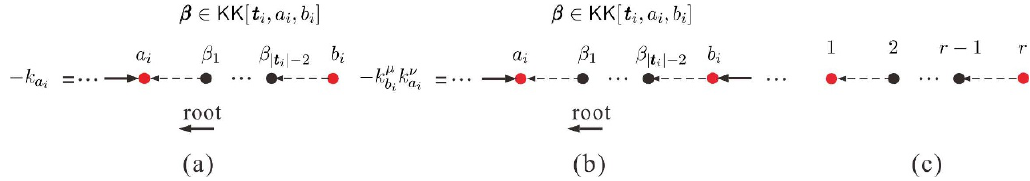
Figure 1 . The graphs for a starting graviton and an internal graviton are correspondingly given by (b).